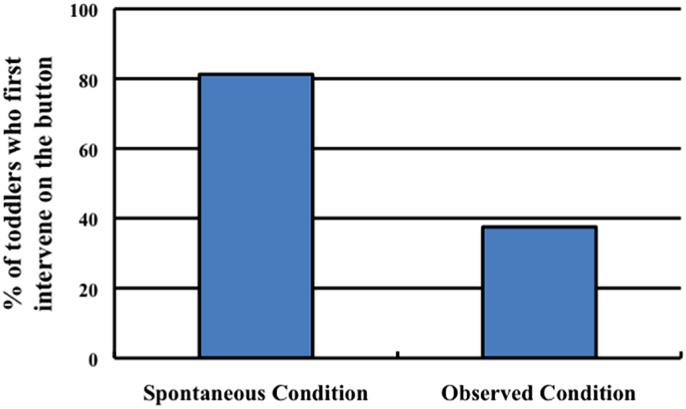
The percentage of toddlers in each condition of Experiment 2 whose first action on the stimuli was to contact the button.